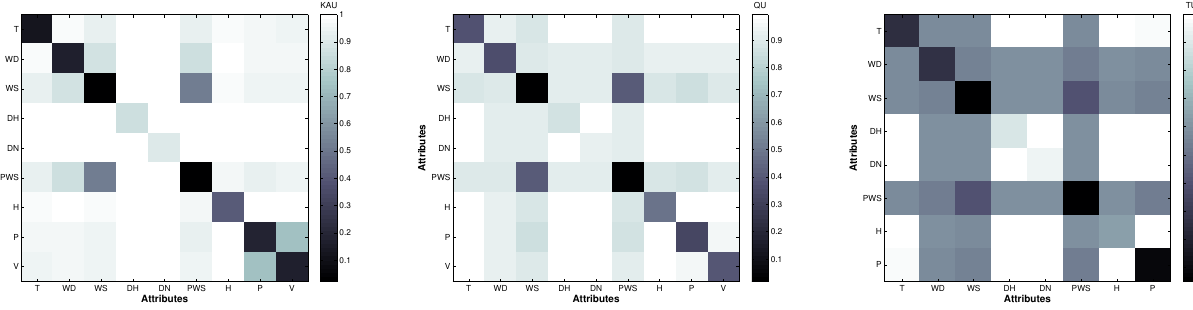
Figure 8. The 5-class decision attribute: Distributions of γ -values of reducts with dual and single